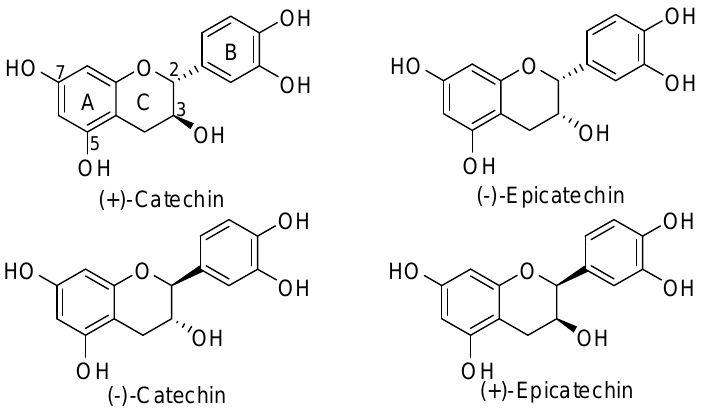
Figure 1. Structures of catechin and epicatechin